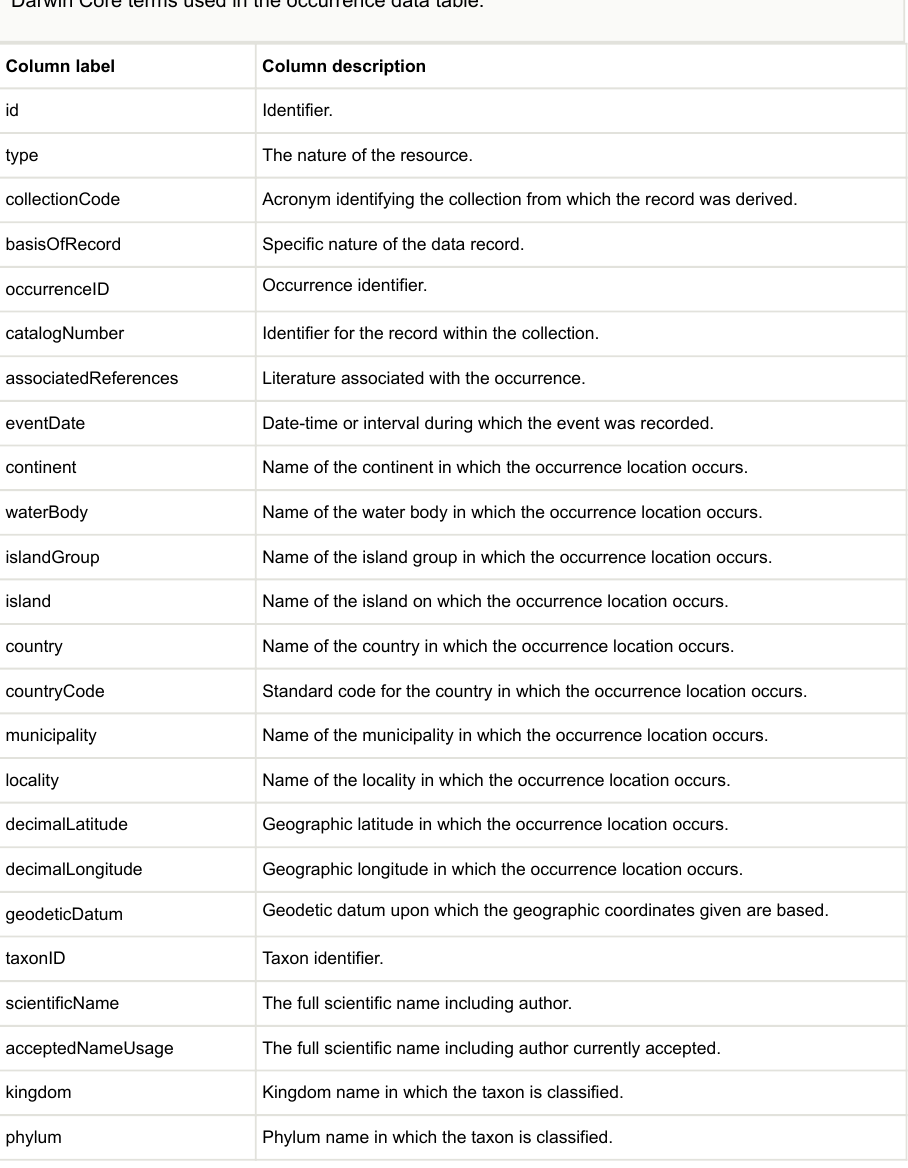
Table 2. Darwin Core terms used in the occurrence data